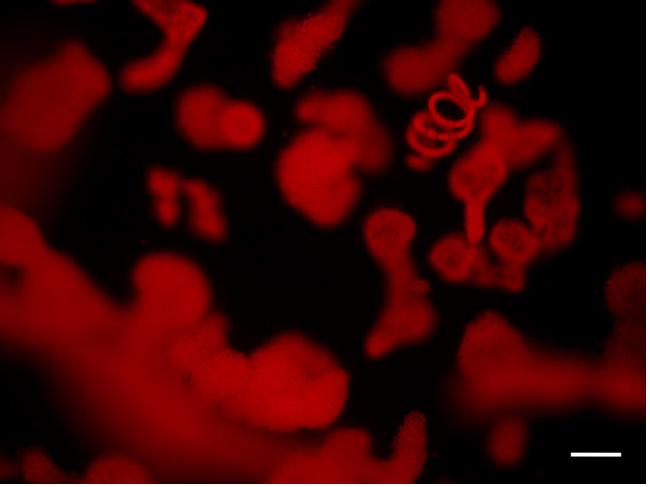
Figure 1. Micrograph of Microcystis and Dolichospermum forming a cyanobacterial bloom in Lake Kastoria, Greece, epifluorescence microscopy (green excitation). Scale bar: 50 μm.